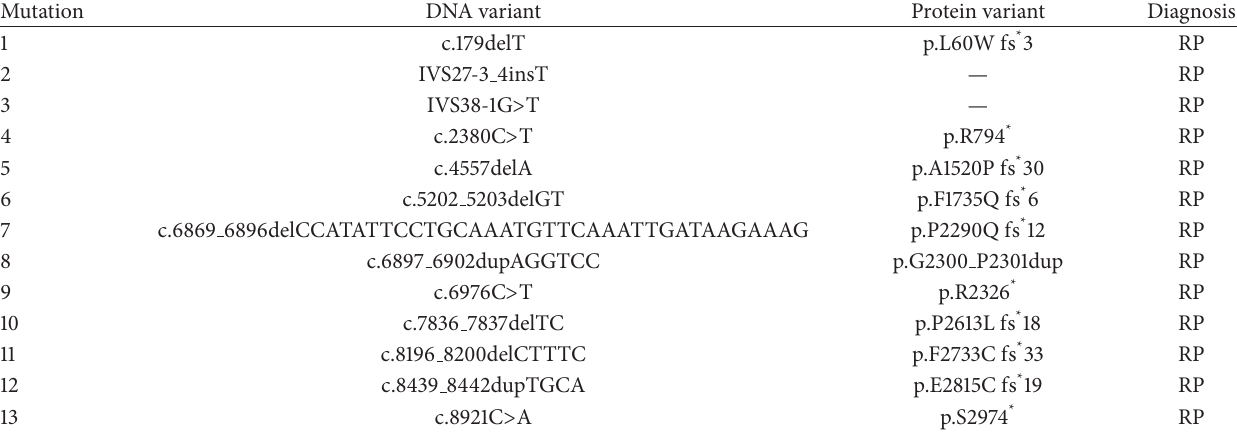
Table 4: Novel truncating and nonsense EYS mutations found in this study.